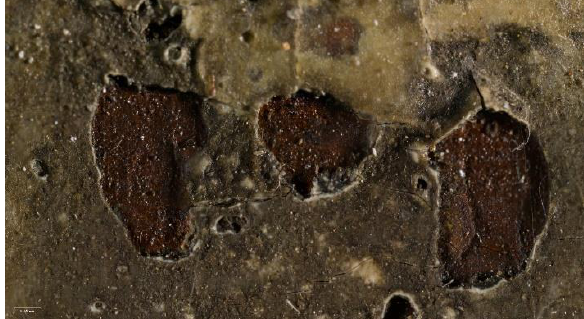
Figure 9. 6-millimetre-wide image crop from the orthomosaic of the second area St. Nicholas icon full body 3D digitization was also successful. The orthomosaic was generated with 7646x10723 pixels and 0.0189 mm/pixels. The DEM was also generated based on the 3D mesh, with a resolution of 4909x5903 pixels and 0.0387 mm/pixel.